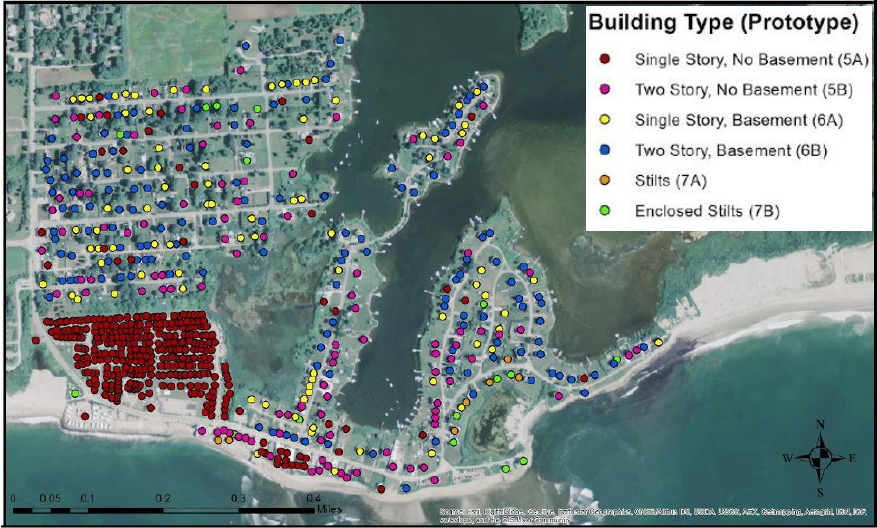
Figure 6. Distribution of structure type (i.e., prototypes) within the study area.